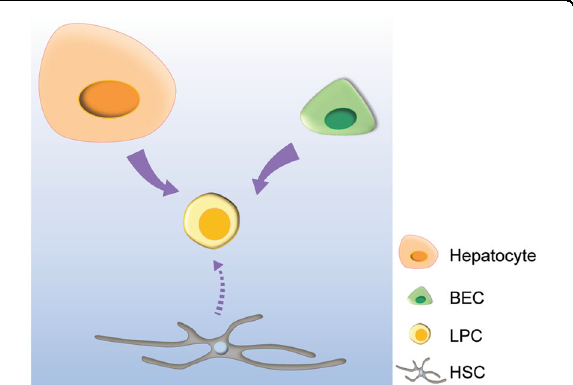
Fig. 2 Origins of LPCs. BECs and hepatocytes can give rise to LPCs in various liver injury settings. HSCs might be an additional source of LPCs in certain liver injury